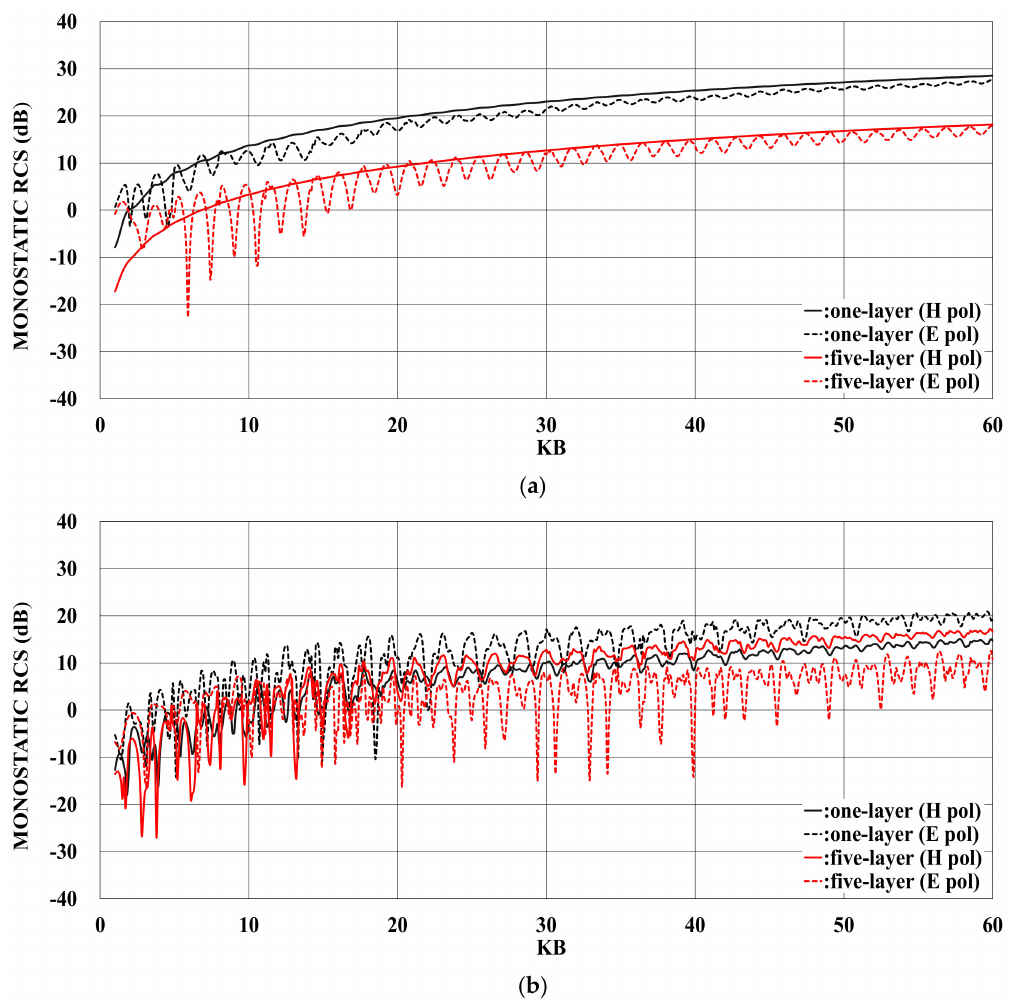
Figure 8. Comparison of the monostatic RCS [dB] versus normalized frequency kb between E- [46] and H-polarizations (this paper), L 1 /2 b = 1.0, kt = 1.57. ( a ) θ 0 = 0 ◦ . ( b ) θ 0 = 60 ◦